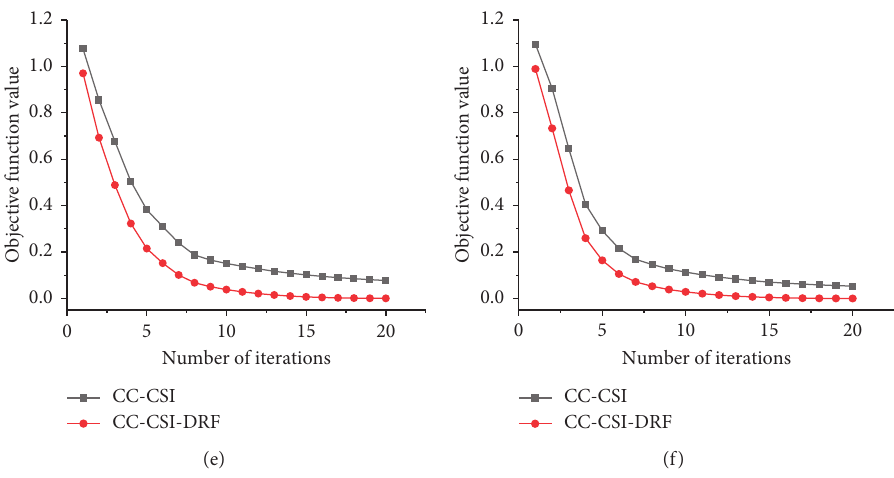
Figure 25: The comparison of convergence curves between CC-CSI and CC-CSI-DGF. (a). The comparison result of “ U -shaped groove.” (b). The comparison result of “two scatterers (asymmetric).” (c). The comparison result of “two scatterers (symmetry).” (d). The comparison result of “single scatterer (TE wave).” (e). The comparison result of “double scatterers.” (f). The comparison result of “single